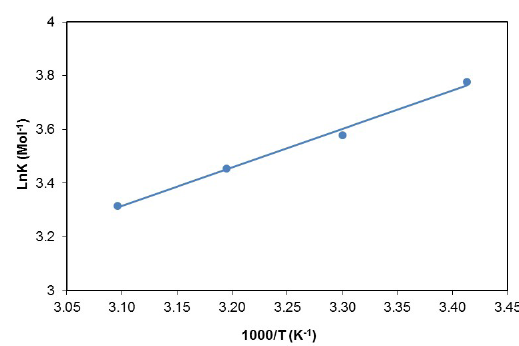
(M -1 ) and 1000/T(K) of TTA ads